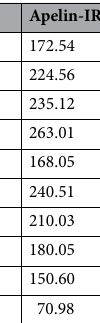
Table 7. Results biological samples. No individual apelin fragments were detected by HPLC–MS/MS, while the RIA method does detect apelin immunoreactivity (apelin-17 + pyroglutamyl apelin-13 + apelin-36). apelin-IR apelin immunoreactivity, HV healthy